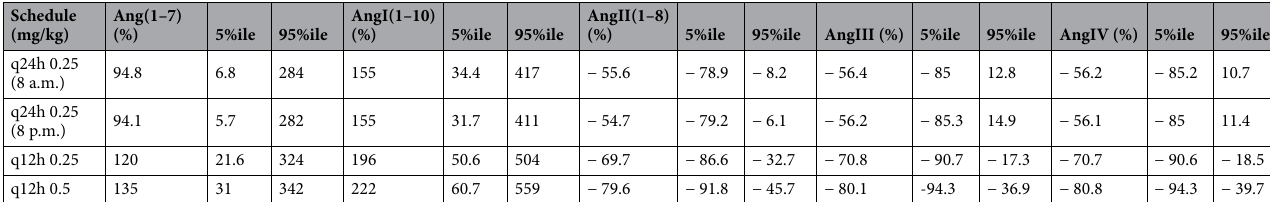
Table 2. Simulation summary. Four administration schedules are compared in this simulation scenario: (1) 0.25 mg/kg every 24 h at 8 a.m.; (2) 0.25 mg/kg every 24 h at 8 p.m.; (3) 0.25 mg/kg twice a day at 8 a.m. and 8 p.m.; (4) 0.5 mg/kg twice a day at 8 a.m. and 8 p.m. 500 individuals were simulated for each scenario (for a total of 2500 individuals, with placebo). Comparisons between schedules are made by calculating